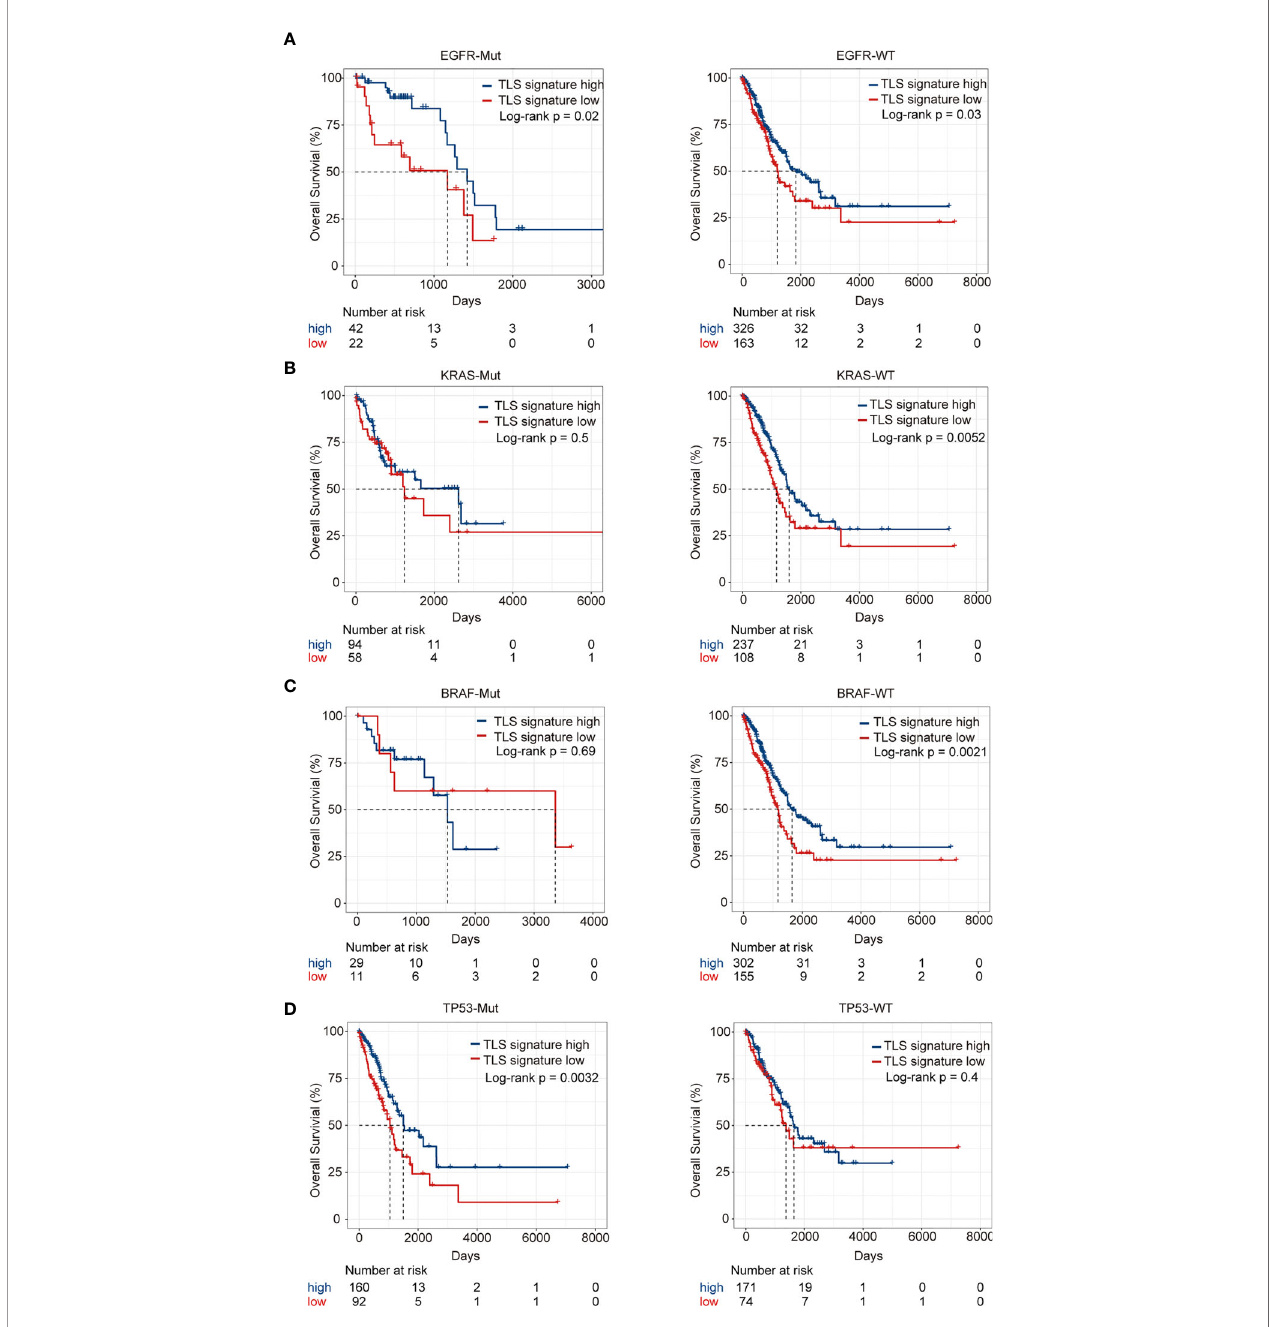
FIGURE 5 | Relationship between TLS signature and OS of patients with given mutation status of driver genes. (A) Differences in OS of patients with wild type (high group n = 326, low group n = 163) or mutant EGFR (high group n = 42, low group n = 22) between the two indicated groups; (B) Differences in OS of patients with wild type (high group n = 237, low group n = 108) or mutant KRAS (high group n = 94, low group n = 58) between the two indicated groups; (C) Differences in OS of patients with wild type (high group n = 302, low group n = 155) or mutant BRAF (high group n = 29, low group n = 11) between the two indicated groups; (D) Differences in OS of patients with wild type (high group n = 171, low group n = 74) or mutant TP53 (high group n = 160, low group n = 92) between the two indicated